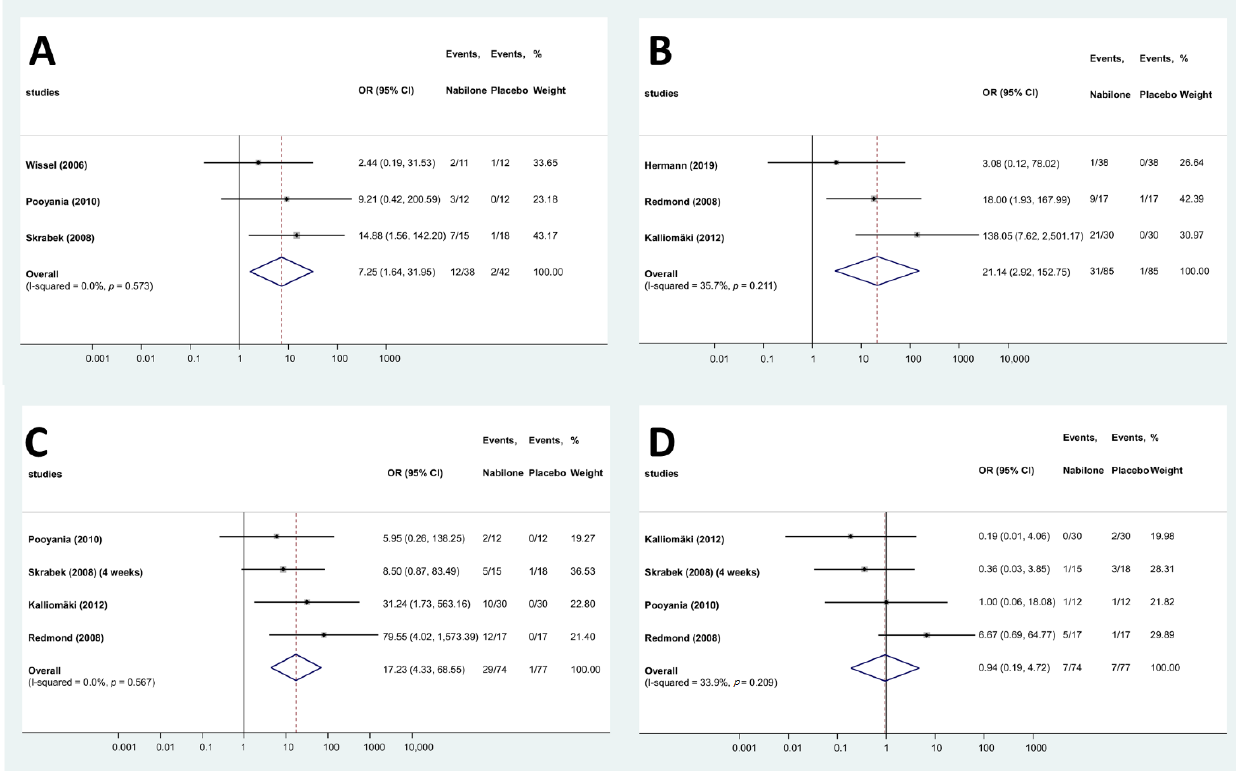
Figure 3. Forest plots of different AEs — nabilone (( A ): drowsiness; ( B ): dizziness; ( C ): dry mouth; ( D ): headache).